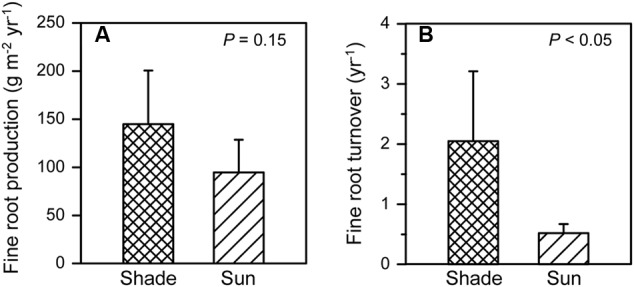
Annual fine root production (A) and turnover (B) in 2012 in the shaded area (i.e., upslope of the stem in a northerly direction) and the sunny area (ca. downslope of the stem in a southerly direction) in vicinity of the isolated 12 P. cembra trees (given are means + SE) in the vicinity of the six study plots in the year 2012.